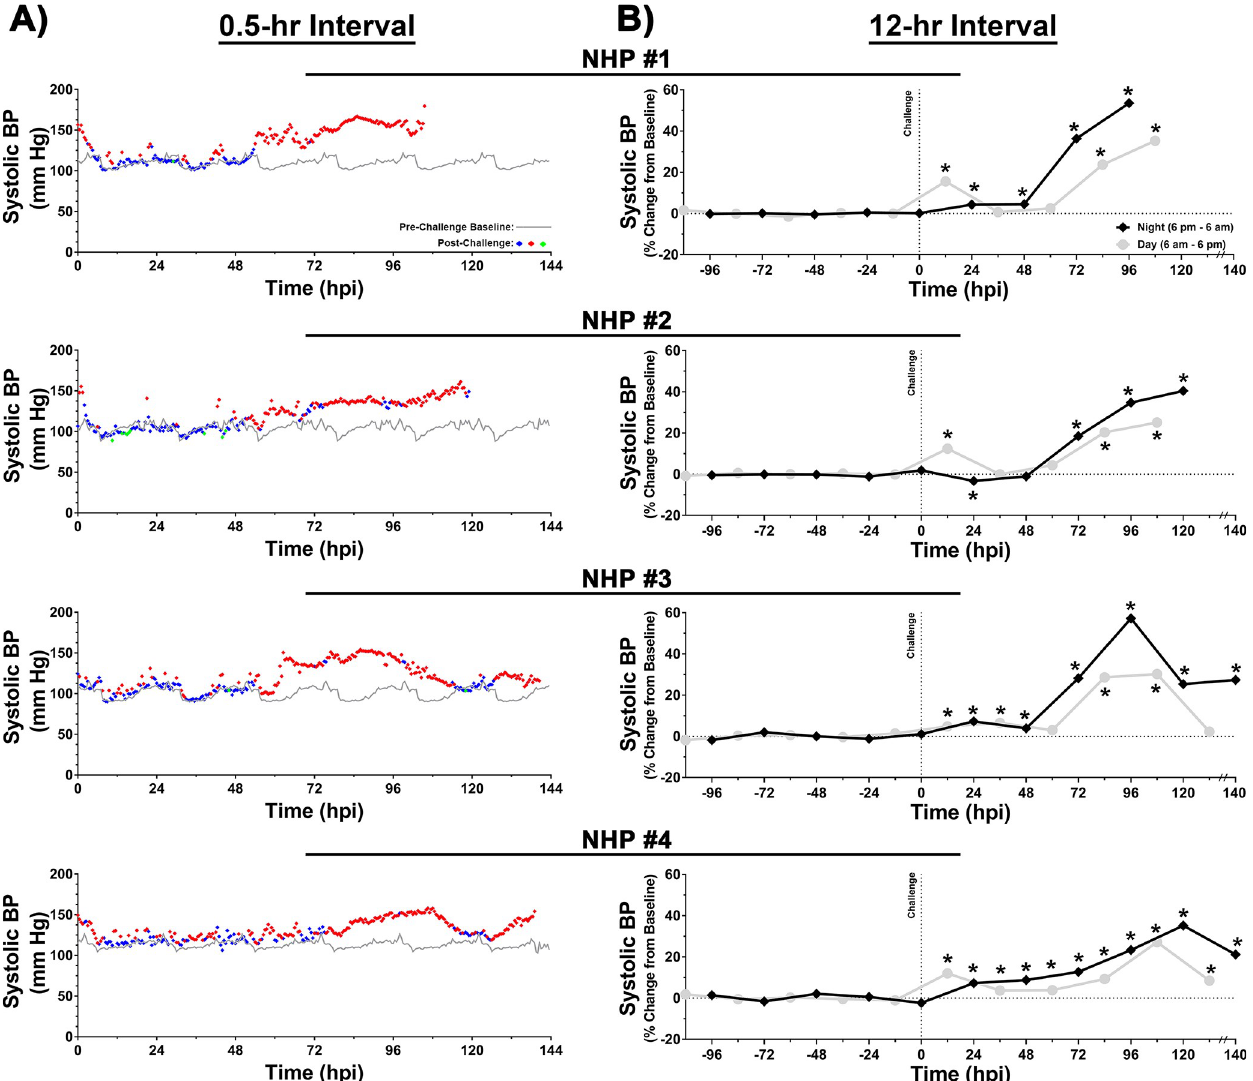
Fig 8. Systolic blood pressure of NHPs pre- and post-EEEV challenge. Data analysis is shown in 0.5- (A) and 12-hr (B) daytime/nighttime intervals. All NHPs were continuously monitored pre- and post-challenge. Pre-challenge baseline systolic blood pressure was measured for five day/night cycles and a 0.5-hr interval baseline average was calculated by averaging raw data of five time-matched day or night time intervals. Forty-eight 0.5-hr interval averages were used to construct a baseline systolic blood pressure for a day/night cycle and is shown as a grey line (A). Post-challenge values within � 3 standard deviations (SD) are indicated with ( ), > 3 SD above baseline are indicated with ( ), and > 3 SD below baseline are indicated with ( ). Percent change from baseline in 12-hr interval is shown in grey (daytime) and in black (nighttime) (B). All raw data from either 12-hr daytime or nighttime intervals were averaged and normalized. The last data point for NHP #3 and 4 is an average of 8 hrs (B). p -values � 0.028 are indicated with � .